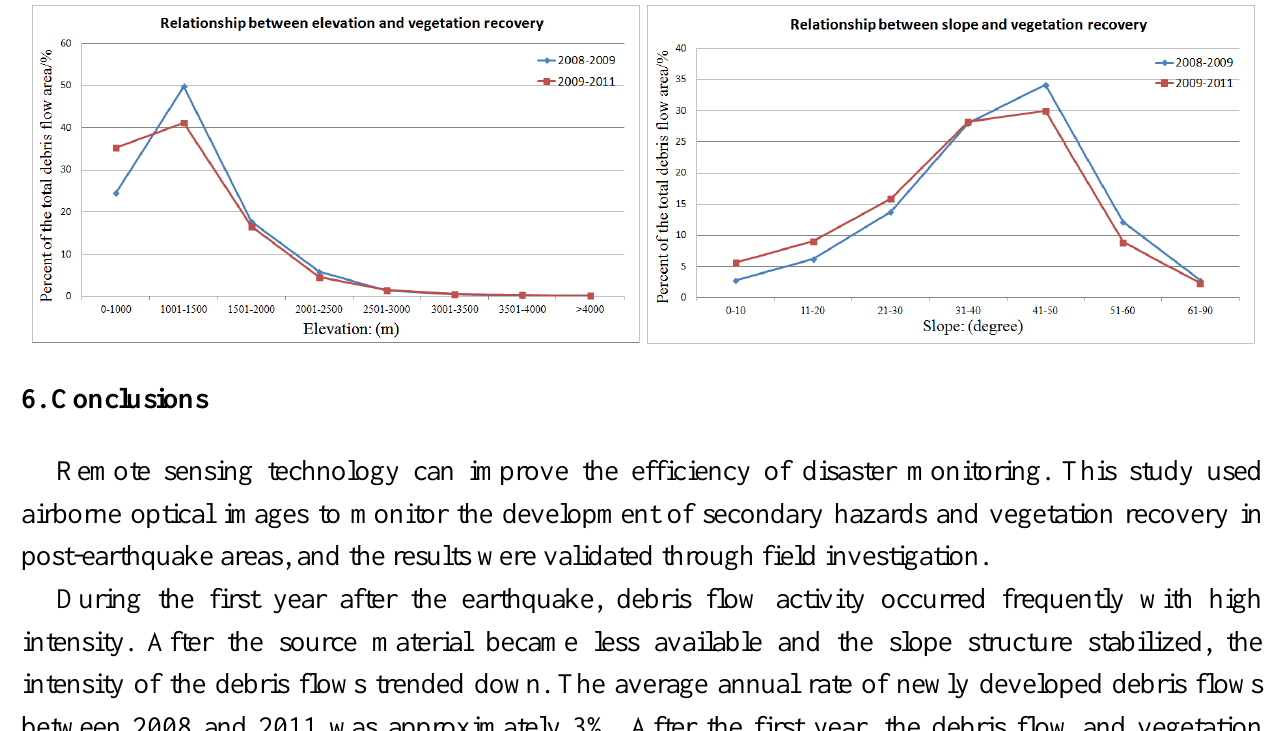
Figure 12. Relationship between vegetation recovery and topographic